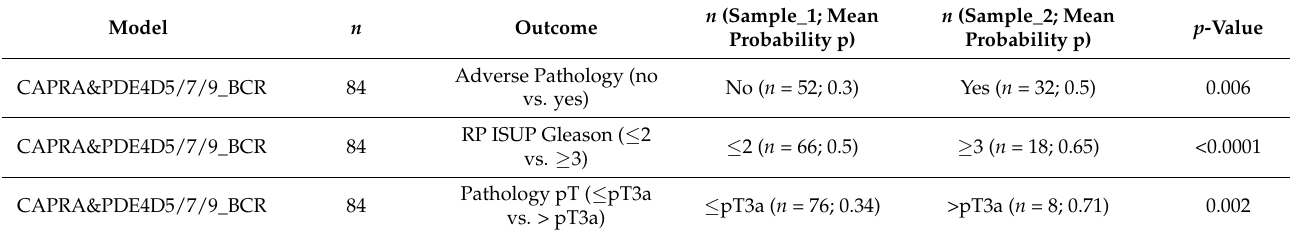
Table 2. Testing of the mean difference CAPRA&PDE4D579_BCR score between adverse pathology outcomes. The Mann–Whitney test for independent samples was used to determine whether there is a difference in the mean risk score as calculated by the CAPRA&PDE4D579_BCR regression model between patient groups with difference post-surgical pathology outcomes. The tested outcomes were: (i) Adverse Pathology defined as any ISUP pathological Gleason grade >2, or pathological pT stage > pT3a, or tumor penetrated prostate capsular status, or pN1 disease; (ii) any ISUP patholog- ical Gleason >2; (iii) any ISUP pathological Gleason >1. The number of patients per outcome group are indicated. The Mann–Whitney p -value is